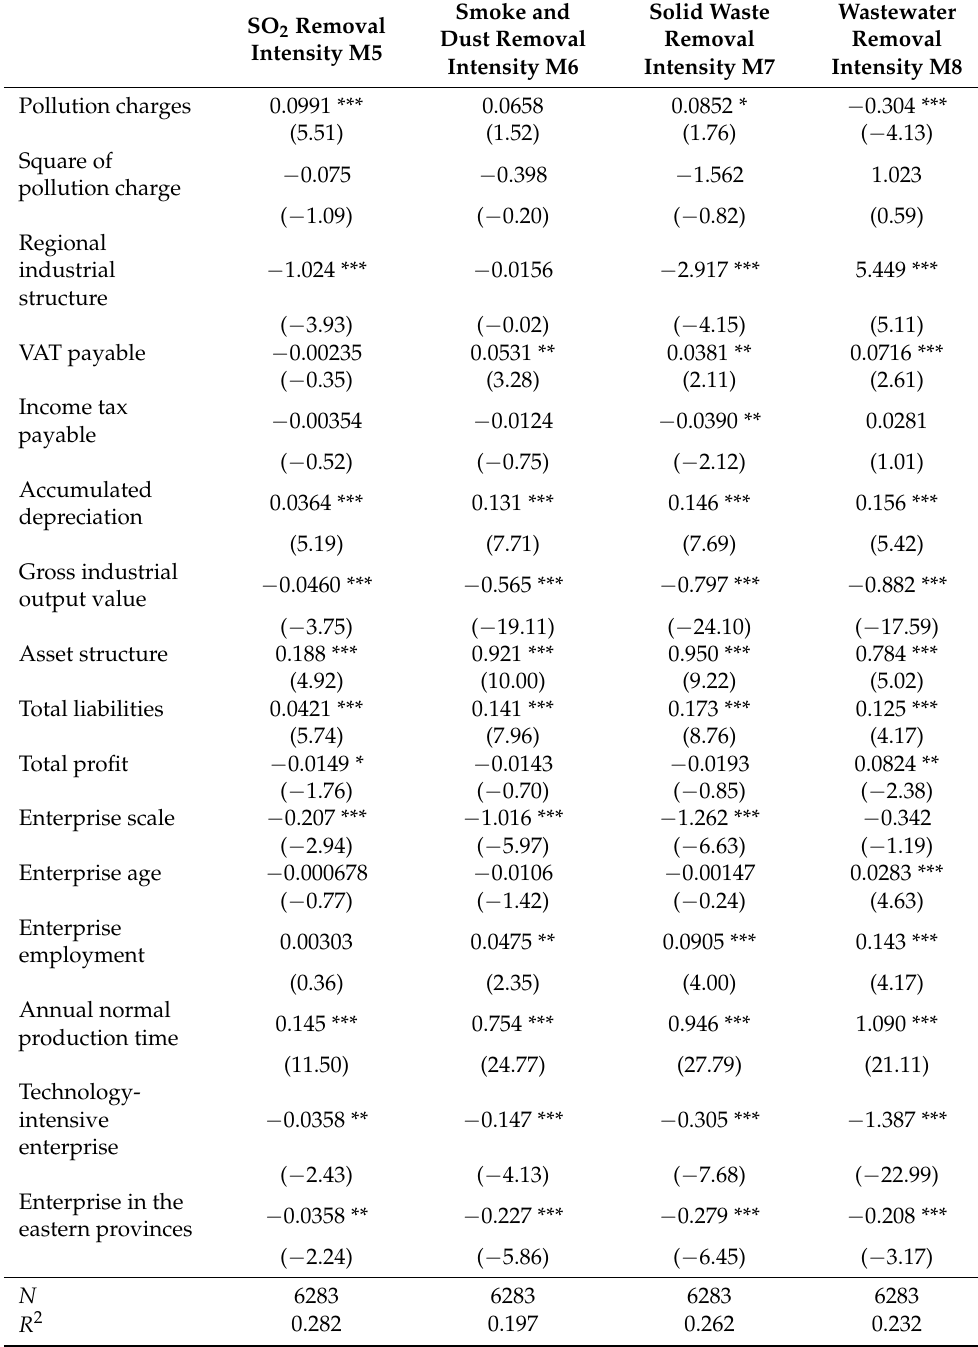
Table 4. Regression results of the impact of pollution charges on enterprises’ end-treatment techno- logical innovation in